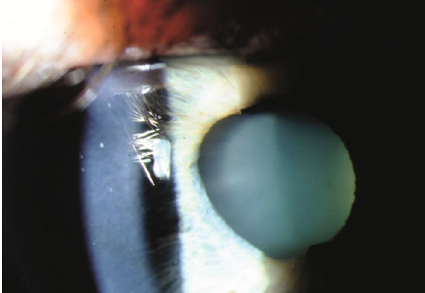
Figure 1: Slit lamp photograph of the right eye of the patient in case 1 depicting corneal stromal haziness and sectoral iris